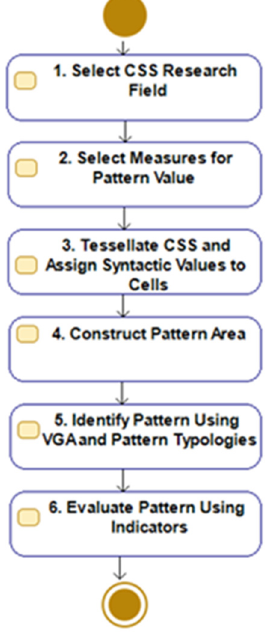
Figure 7. Algorithm of SP identification (simplified).